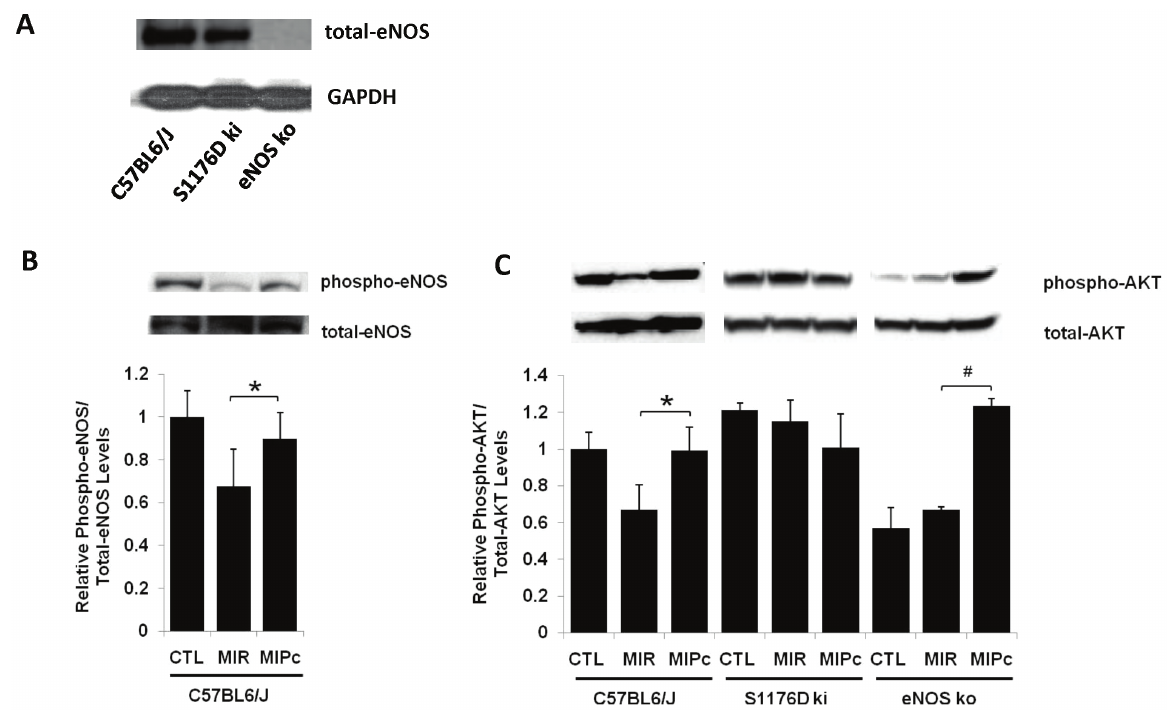
Figure 2. Postconditioning activates Akt and eNOS. A. Western blot of total eNOS and GADPH in WT (C57BL6/J), S1176D mice (S1176ki), and eNOS ko mice. B. Western blot demonstrating phosphorylation (Ser1176) and total protein levels of eNOS in wild-type mice under conditions of control (CTL), MIR, and MIPc. C. Representative Western blot demonstrating phosphorylated (Ser473) and total protein levels of Akt. Densities (arbitrary units, AU) show that MIPc phosphorylates Akt in WT and eNOS ko mice. n=5 per group. Data are expressed as the mean 6 SD. *P , 0.05.